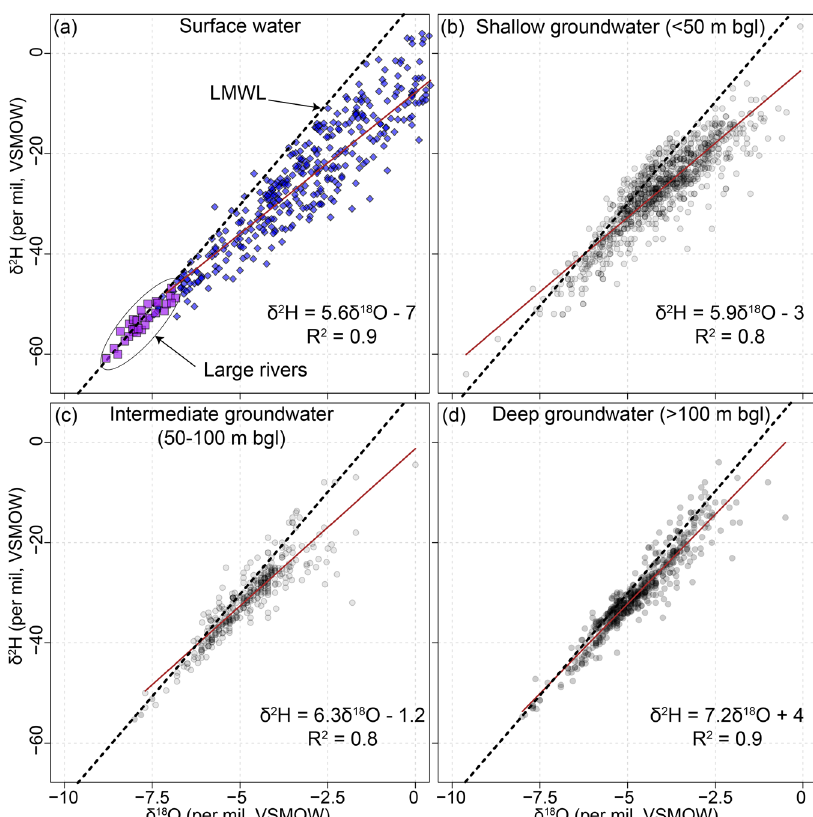
Fig. 4 Surface and groundwater isotope ratios. Stable isotope values of surface water ( a ), shallow ( b ), intermediate ( c ), and deep ( d ) groundwater in the Bengal Basin. The local evaporation line (LEL) for surface water ( a ) is shown in the dark red line. Purple squares and blue diamonds in panel ( a ) are the isotope ratios of large rivers and standing water, respectively. Dark red line in panels ( b – d ) are the respective groundwater lines for shallow, intermediate, and deep wells. The equations are the best- fi t evaporation line (panel a ) and groundwater lines (panels b – d ). The Black dashed line in each panel is the LMWL. For clarity, very enriched standing and groundwater samples ( δ 18 O>0 ‰ ) and depleted river samples ( δ 18 O< − 10 ‰ ) have been removed from the fi gure. The isotopic range of δ 18 O and δ 2 H ( x - and y -axis) for the surface and groundwater are smaller than the range of precipitation δ 18 O and δ 2 H (Fig.